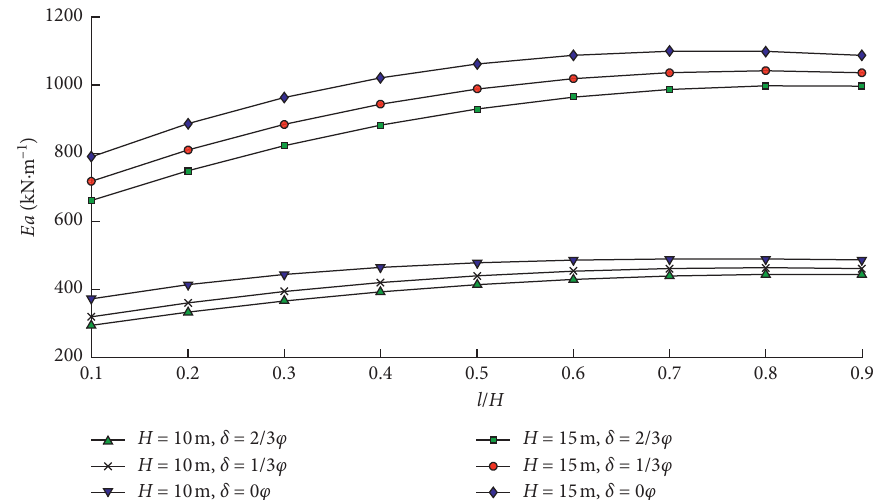
Figure 10: The resultant earth pressure under different l / H and δ values.